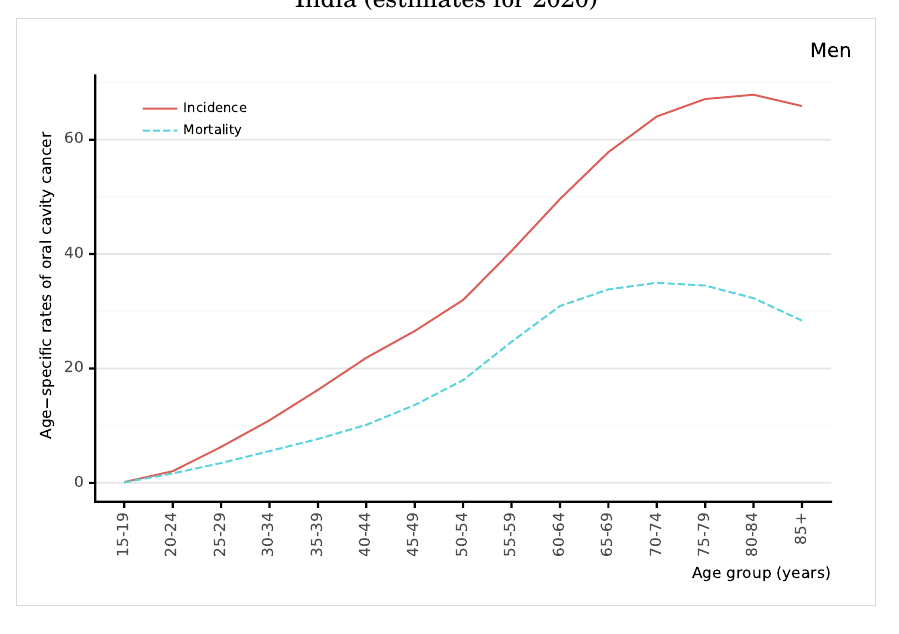
Figure 46: Comparison of age-specific oral cavity cancer incidence and mortality rates among men in